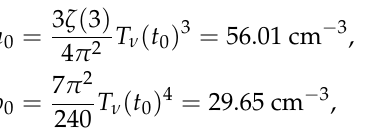
≡ δρ ν / ρ ν and number i i 0